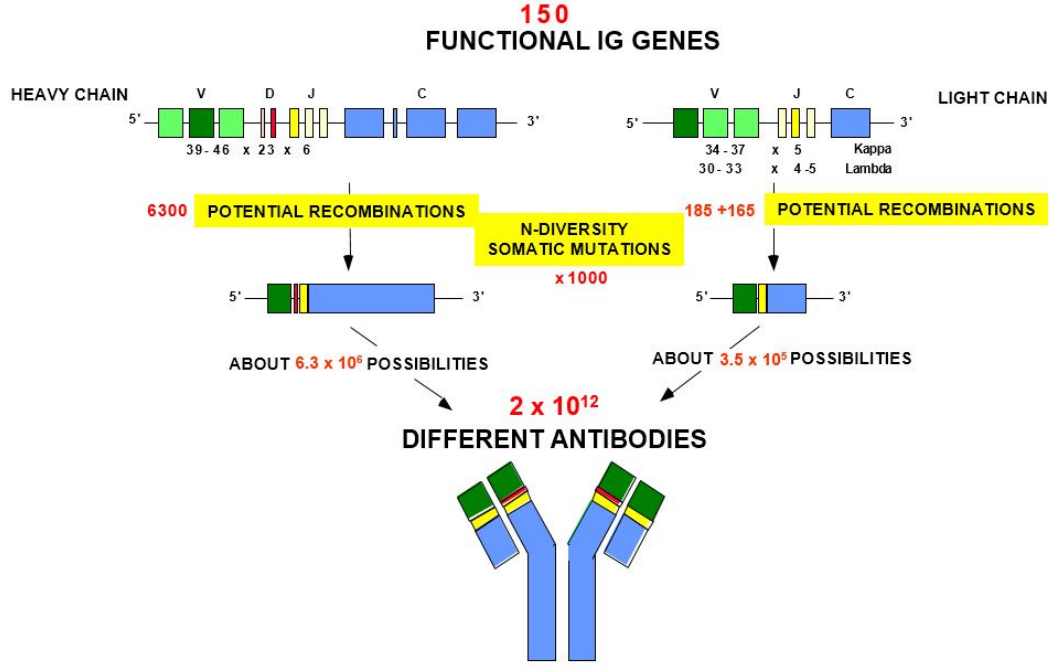
Figure 6. Molecular synthesis of the immunoglobulins (IG) or antibodies and origin of their diversity. The gene numbers are from the human ( Homo sapiens ) IGH, IGK and IGL loci. The molecular mechanisms creating the diversity of the antigen receptors of the adaptive immune responses include the combinatorial diversity (V-(D)-J rearrangements), the junctional diversity (including the N-diversity), the somatic hypermutations (SHM) and the pairing of the heavy and light chains. Altogether the mechanisms of diversity that occur at the DNA level in the B cell result in about 6.3 × 10 6 and about 3.5 × 10 6 possibilities of heavy and light chains, respectively, and the pairing of one heavy chain with one light chain (the antibody is made of two identical heavy and light chains) results into a potential repertoire of 2 × 10 12 different antibodies. The two inter-H-L and the inter-H-H disulfide bridges which depend on IG or antibody class or subclass are not shown. Only the core gene regions are represented. V = V-REGION (in green), D = D-REGION, J = J-REGION, C = C-REGION (in blue). The gene regions involved in the H chain V-D-J and L chain V-J rearrangements are highlighted: V (in dark green), D (in red) and J (in yellow). (With permission from M-P. Lefranc and G. Lefranc, LIGM, Founders and Authors of IMGT ® , the international ImMunoGeneTics information system ® , http: //